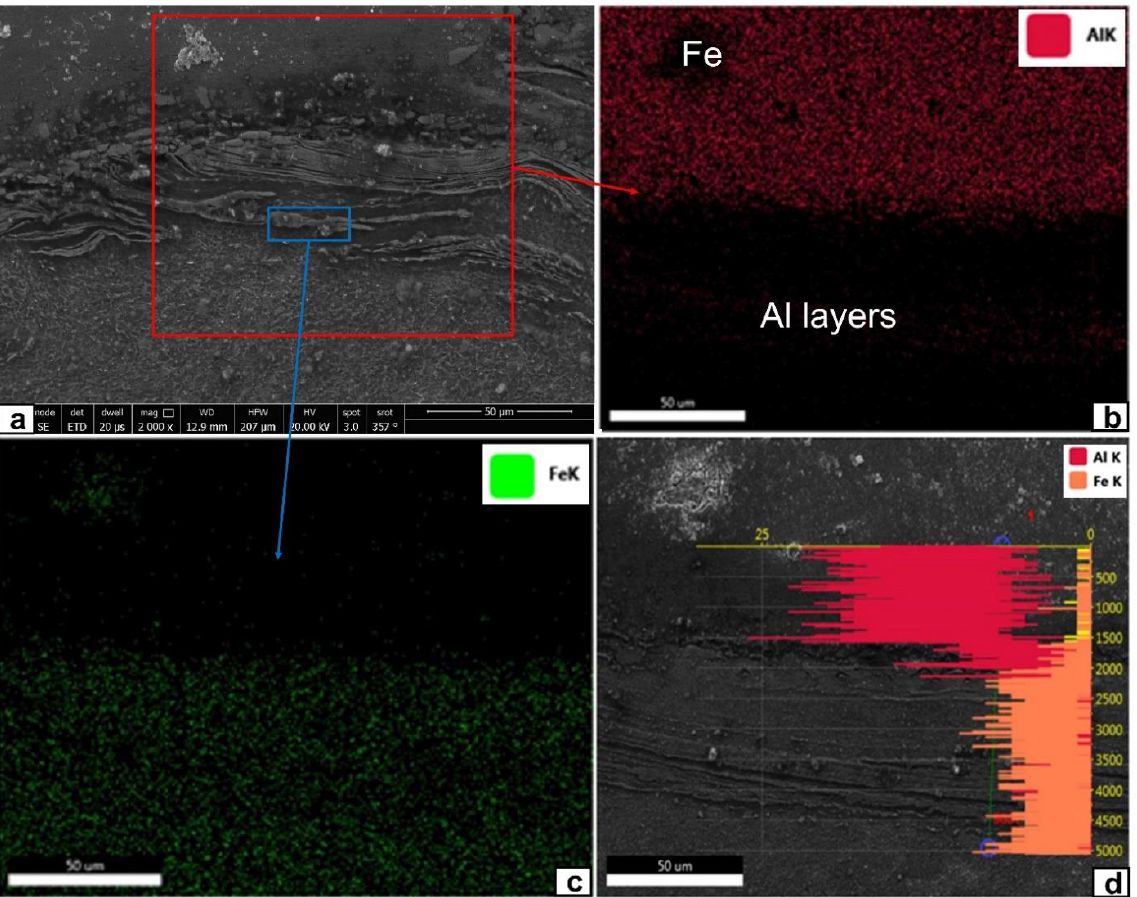
Figure 5. EDS mapping of the aluminum/steel interface produced with high FSP rotation speed of 1500 rpm and pin length of 3 mm: ( a ) steel–aluminum interface, ( b ) EDS mapping for Al, ( c ) EDS mapping for Fe, and ( d ) relative ratio between Fe and Al in the interface.